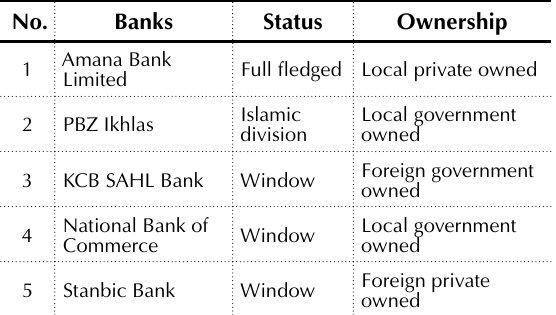
Table 1. Number of Islamic banks in Tanzania